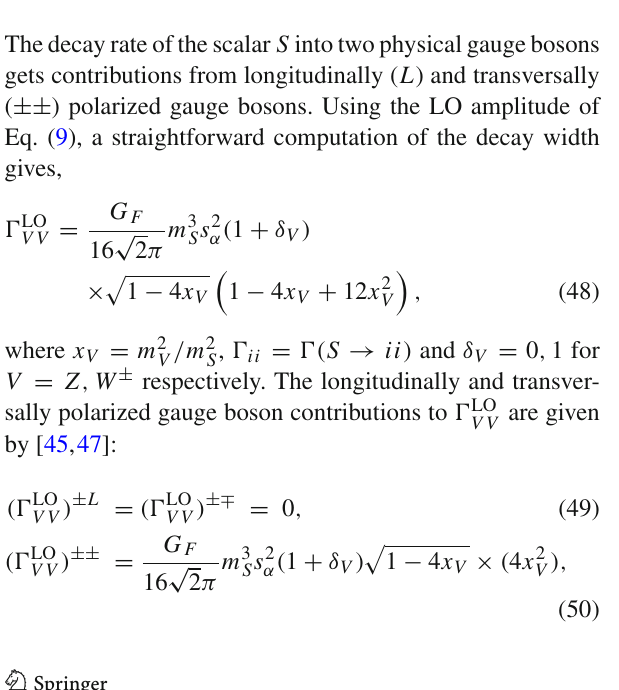
is defined in Appendix